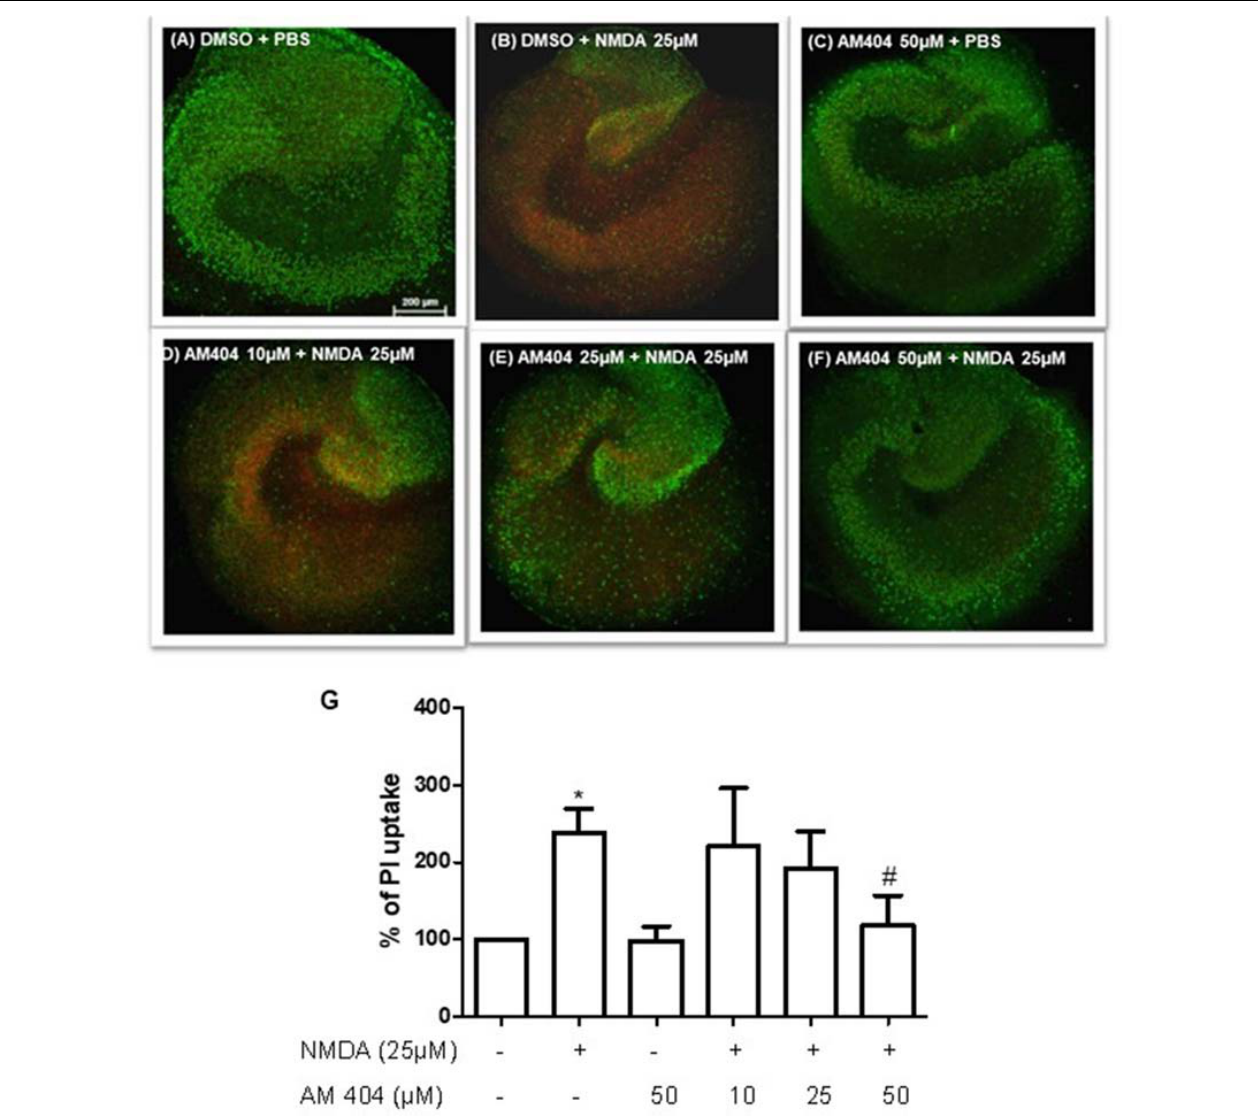
FIGURE 1 | Effects of N-arachidonoylphenolamine (AM404) on excitotoxicity in mouse hippocampal slices cultures [ n = 3 organotypic hippocampal slices cultures (OHSCs)/group]. (A–F) Representative confocal images of the immunostaining with propidium iodide (PI; red) and with the neuronal nuclear marker NeuN (green). (G) Quantitative analysis of the PI fluorescence. The results are expressed as mean ± SEM. ∗ p < 0.05 with respect to negative control and # p < 0.05 compared with N-methyl-D-aspartic acid [NMDA; 25 µ M; one-way analysis of variance (ANOVA), Newman–Keuls test].